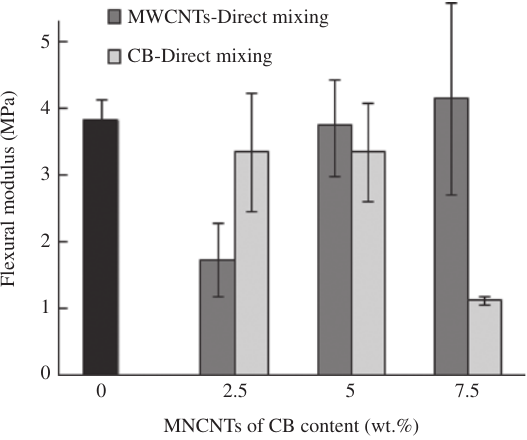
Figure 8: The effect of the MWCNTs and CB on the flexural modulus of the PP/SG/xGnP